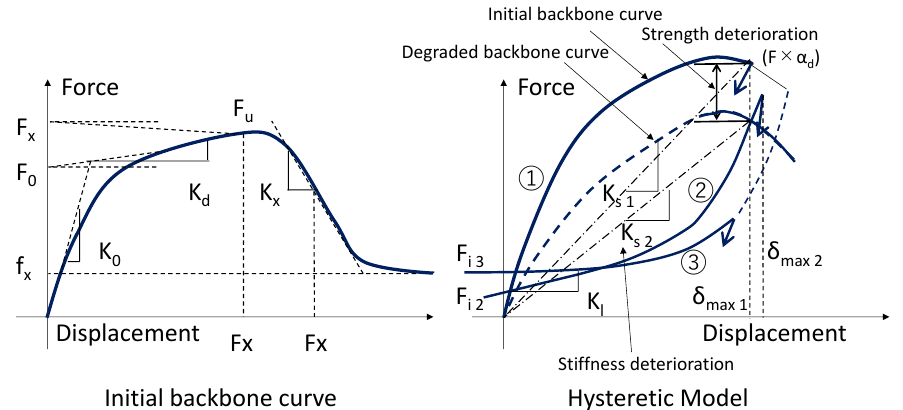
Figure 3. Hysteretic model of the improved EPHM [15]. (The number means the number of repetitions.).